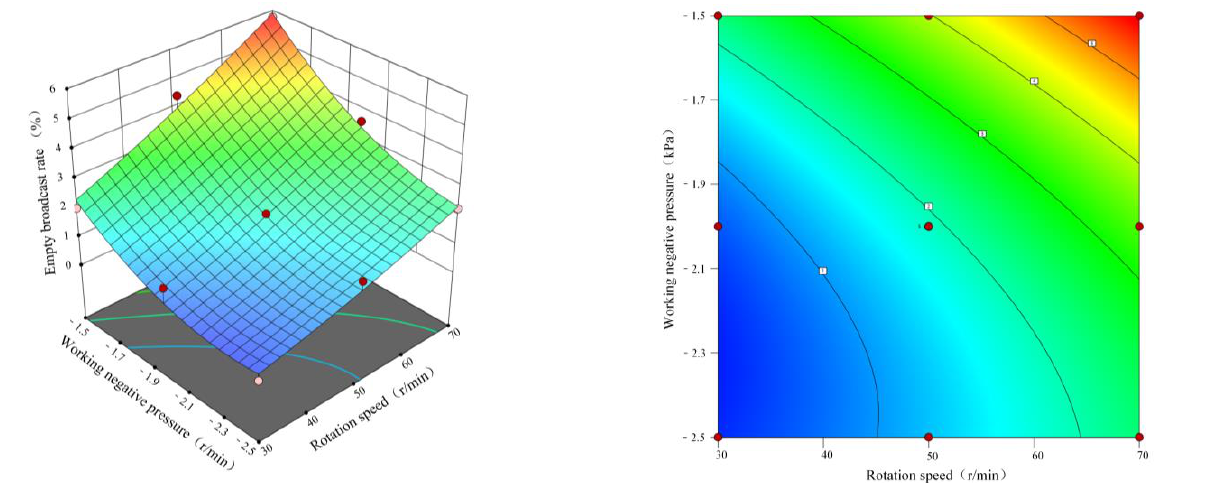
Figure 19. Response surface diagram of the empty broadcast rate.